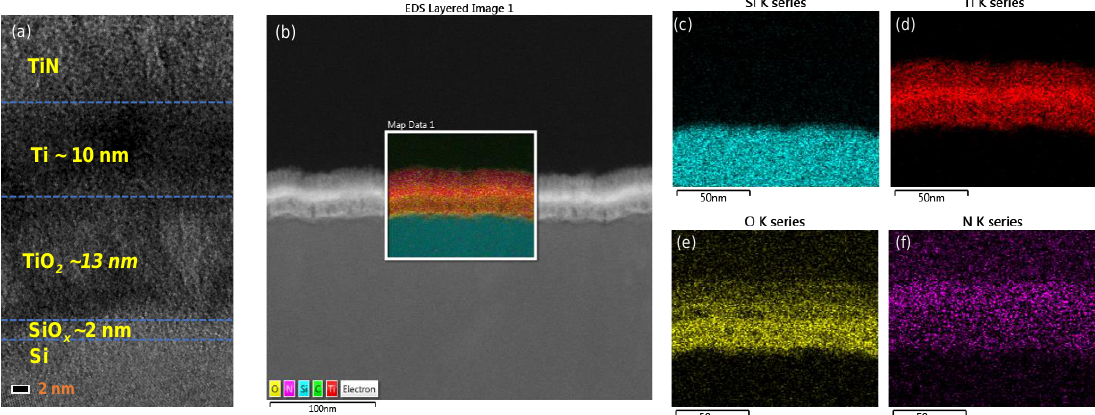
The critical electric field in the TiN/Ti/TiO 2 /SiO x /Si device system is slightly smaller than the values (6 to 8 MV/cm) reported in previous study [55]. This is because some defects are induced in the SiO x layer in an LRS. Figure 1. ( a ) TEM image TiN / Ti / TiO 2 / SiO x / Si device; ( b ) energy-dispersive X-ray spectroscopy (EDS) layered image in scanning transmission electron microscope (STEM); each element (( c ) Si, ( d ) Ti, ( e ) O, ( f ) N) of TiN / Ti / TiO 2 / SiO x / Si device.